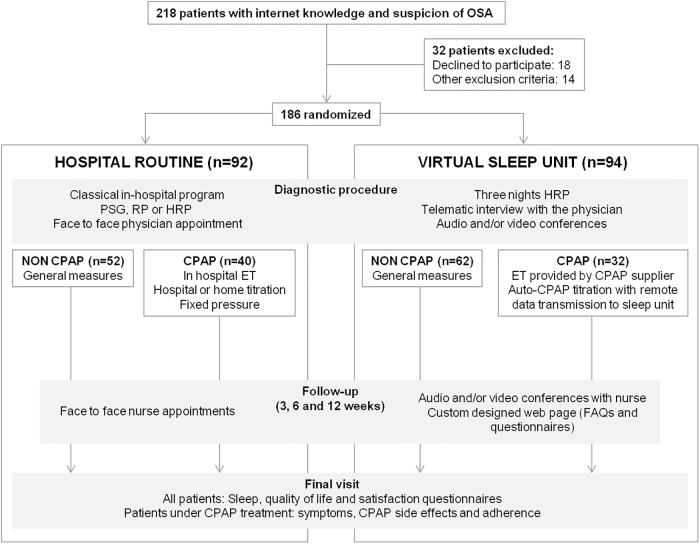
Study flowchart.Protocol flowchart. ET: educational training. FAQs: frequent asked questions. HRP: home respiratory polygraphy. PSG: full polysomnography. RP: respiratory polygraphy.